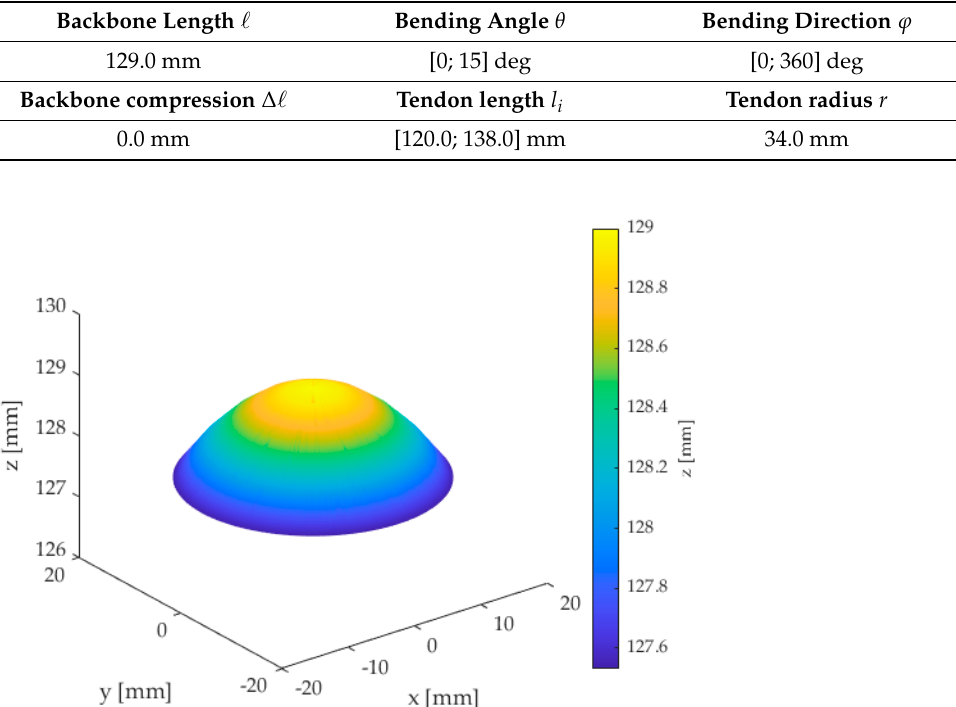
Table 2. Size and motion parameters of the torso mechanism prototype in Figure 2.